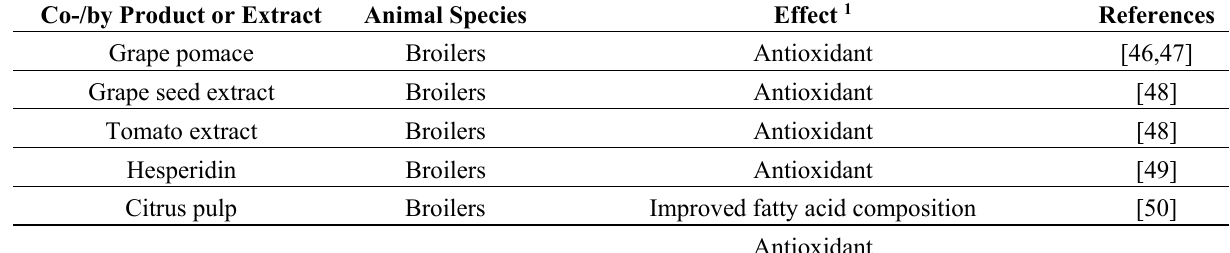
Table 3. Effects of fruit and vegetable processing co-products (either as bulk material or high value component) on farm animal product quality (selection divided by type of co-product and